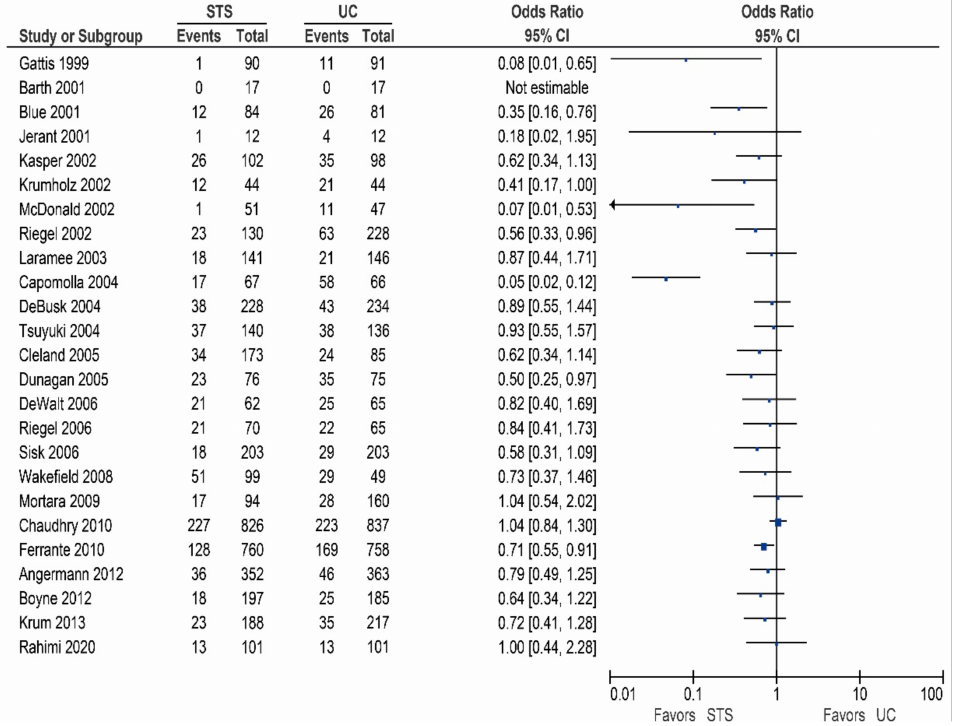
Figure 3. Heart Failure (HF)-related hospitalizations in patients receiving structured telephone support versus usual